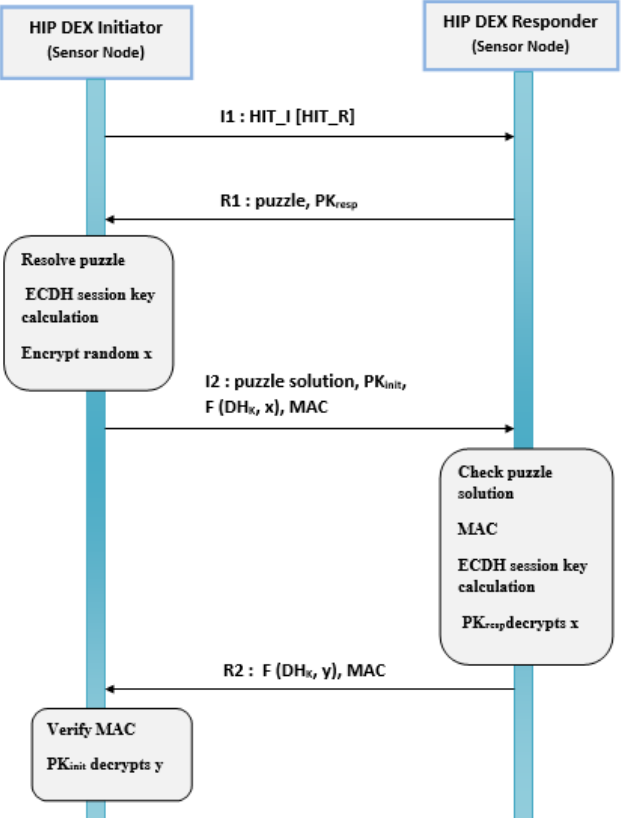
Figure 1. Handshake exchanged messages of standard HIP